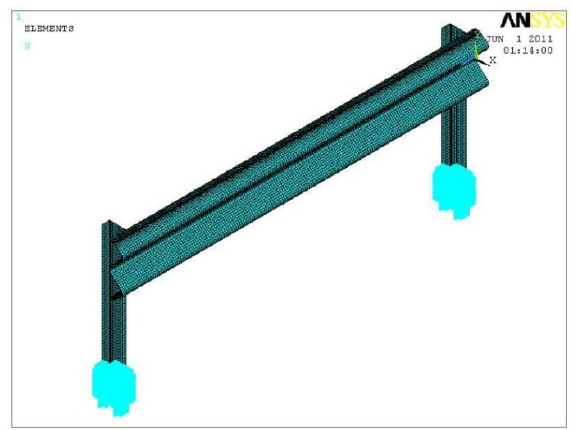
Fig. 9. The computer model of the guardrail with fixed (conc- reted) posts (boundary conditions in cyan colour) is divided into finite elements (our